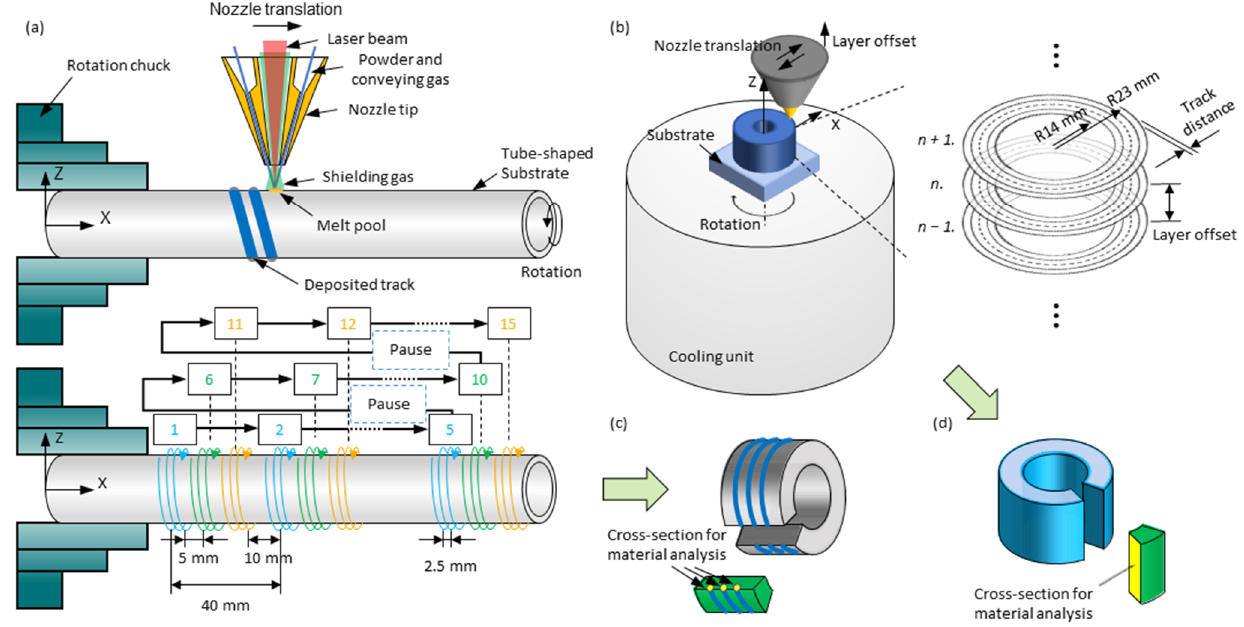
Figure 3. Schematic illustrations of the process strategy for fabricating ( a ) single tracks and ( b ) 3D- parts, and of their respective ( c , d ) sampling approaches.